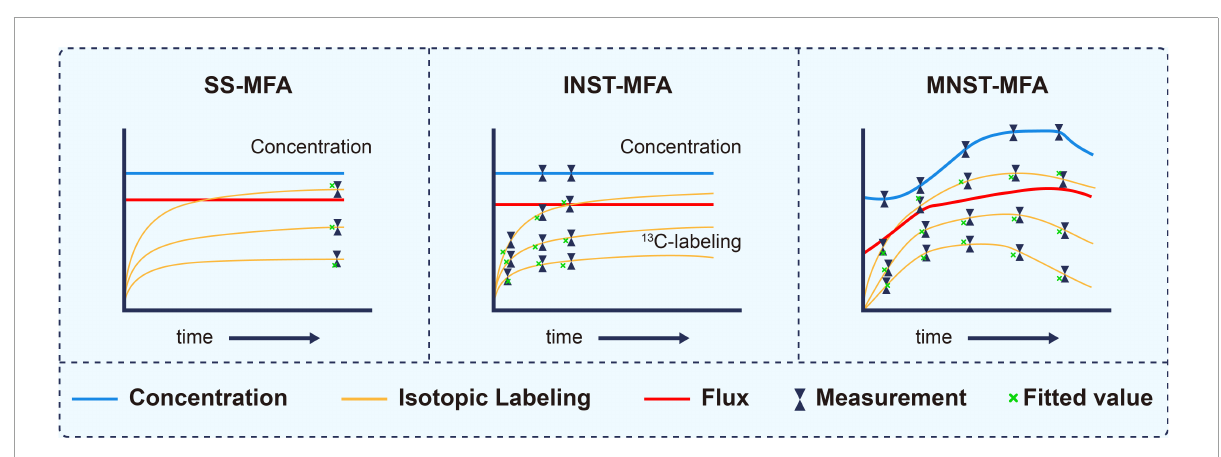
FIGURE3 Characterization of different 13 C metabolic flux analysis methods, modified from (37). The essential distinguishing feature between these methods are whether isotopically stationary state is reached and whether metabolic steady state is assumed. SS-MFA, Stationary State 13 C Metabolic Flux Analysis; INST-MFA, Isotopically Non-stationary 13 C Metabolic Flux Analysis; MNST-MFA, Metabolically non-stationary 13 C metabolic flux